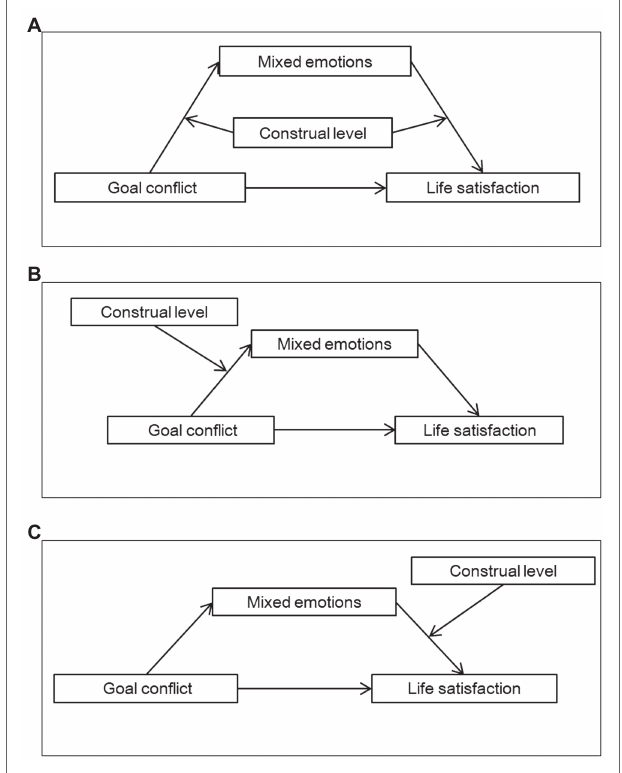
FIGURE 1 | The moderated mediating